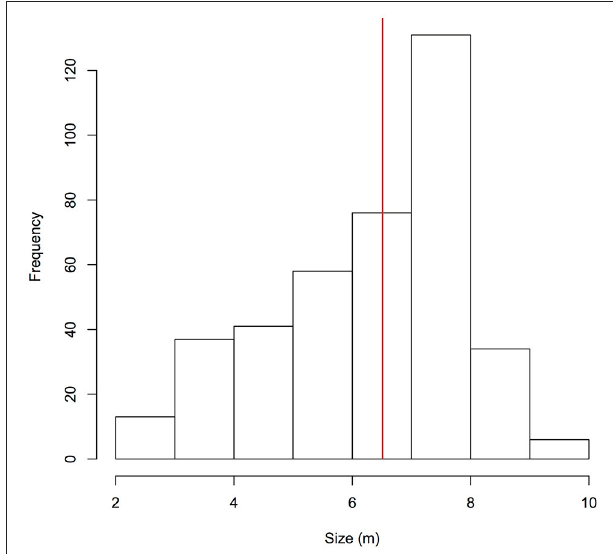
FIGURE 2 | Size distribution of whale sharks identified in Donsol. The red line indicates the mean size of individuals (6.5m).